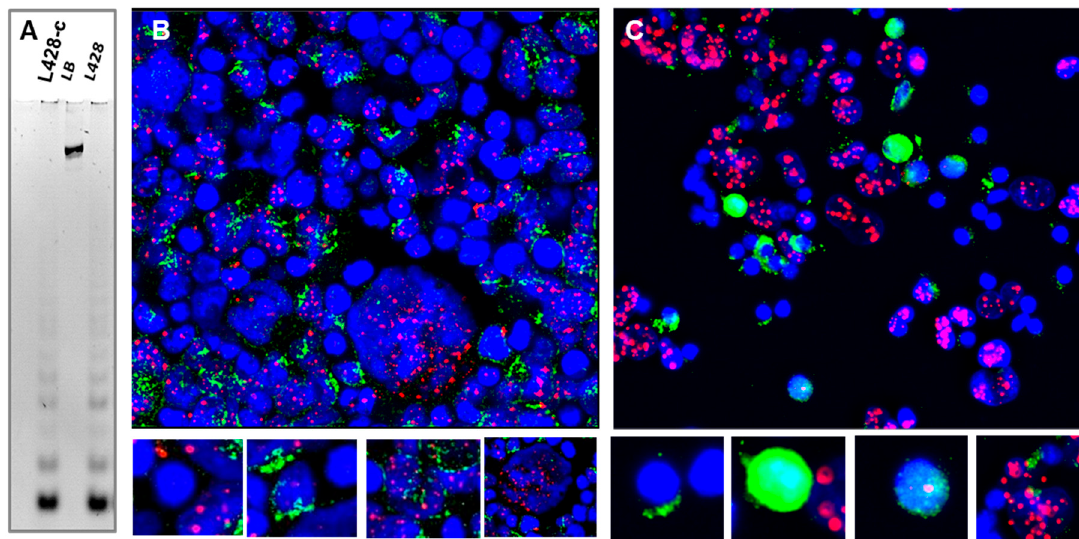
Figure 15. Telomerase expression in HL cells grown in vitro and in vivo. ( A ) High telomerase activity detected in the L428-c subline relative to that of the parental cell line (L428). Lysis buffer (LB) served as an internal control for the amplification, excluding false negatives. ( B ) Immunofluorescent staining of hTERT (green) and PML (red) demonstrates high telomerase expression in small cells of L428-c, as well as the presence of cells expressing both hTERT and PML. There are also large cells with a morphology similar to that of HRS cells, with very low hTERT expression and a large number of PML bodies. ( C ) Populations of HL cells recovered from the livers of mice included small cells with high telomerase expression, cells expressing both hTERT and PML, and large cells with a large number of PML bodies. We also detected cells with no expression of hTERT or PML among L428-c cells and HL cells recovered from the livers of mice (40× magnification).